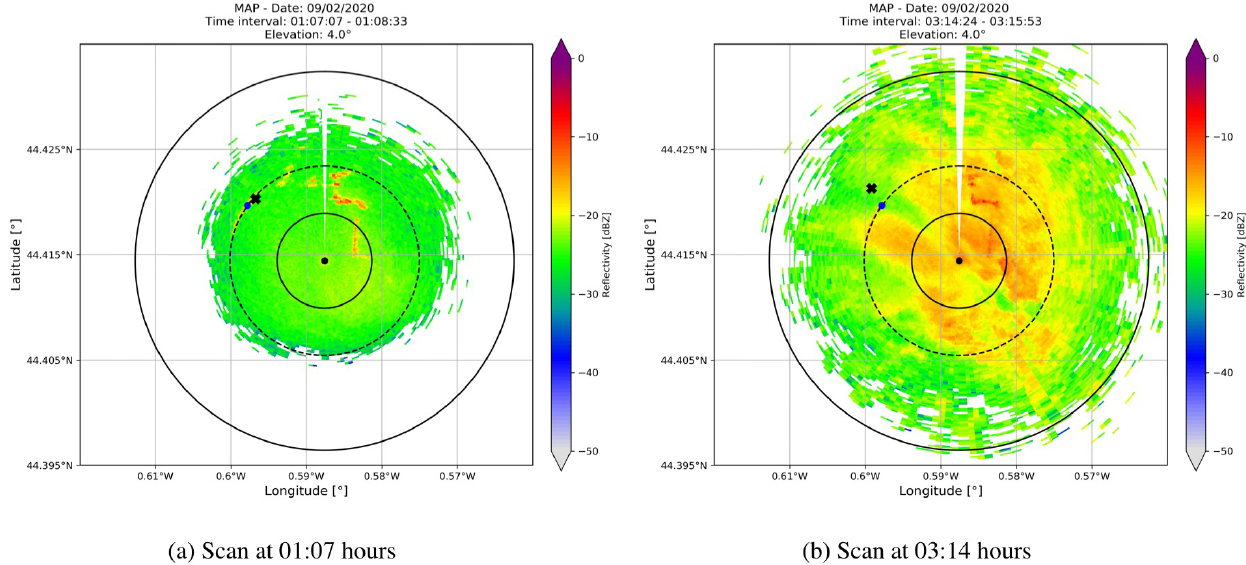
Figure 8. Scans of BASTA-mini collected for fog at 4 ◦ elevation angle. The vertically pointing radar shown as a blue dot was located 1km away from the scanning radar, and the cross represents the location of the balloon.